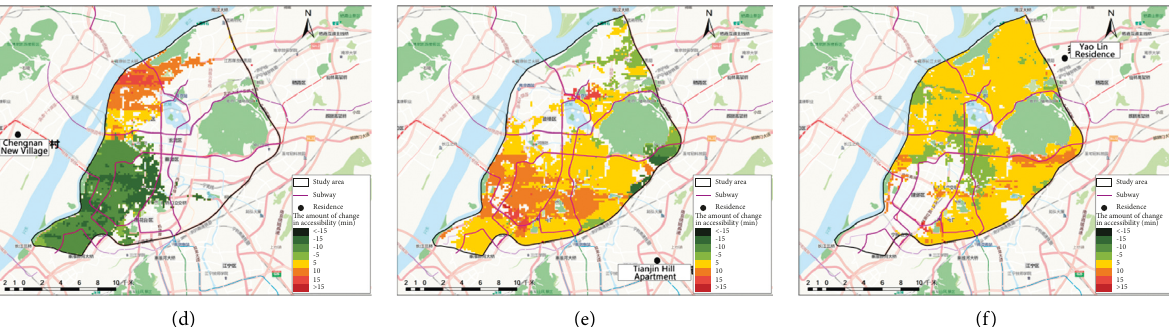
Figure 4: Amount of change in traffic accessibility under the impact of 25 daily snowstorms. (a) Jiangbei Wanhui Residence, (b) Dongshan Culture Park, (c) Xianlin Poly Amethyst, (d) Jiangbei Chengnan Xincun, (e) Dongshan Tianjingshan Apartments Chunxiu, and (f) Xianlin Yao Lin